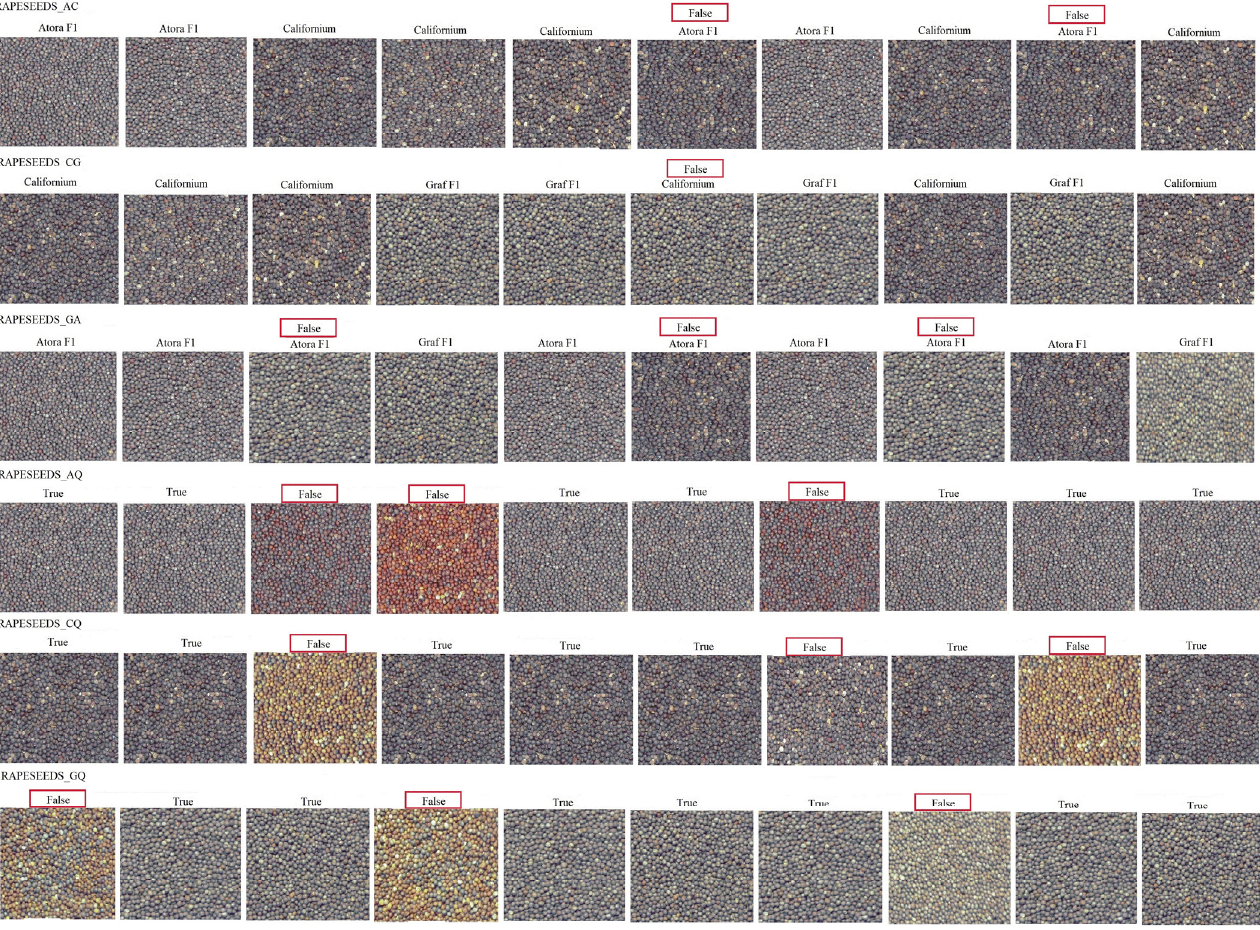
Figure 6. Input of oilseed rape seed images with their predicted labels. Red box indicates incorrect model reading